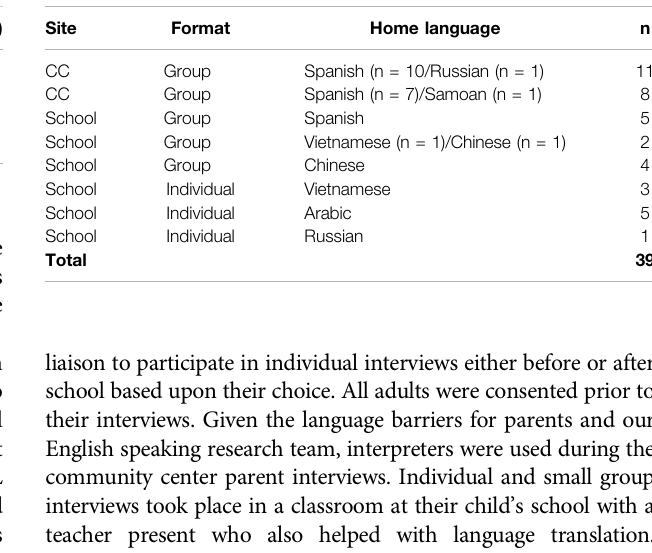
TABLE 2 | Parent sample demographics (CC (cid:1) Community